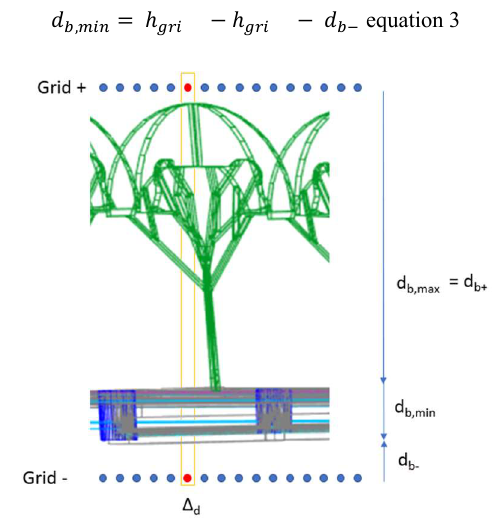
Figure 9: The calculation of d b,min for the calculation of the volume in the second